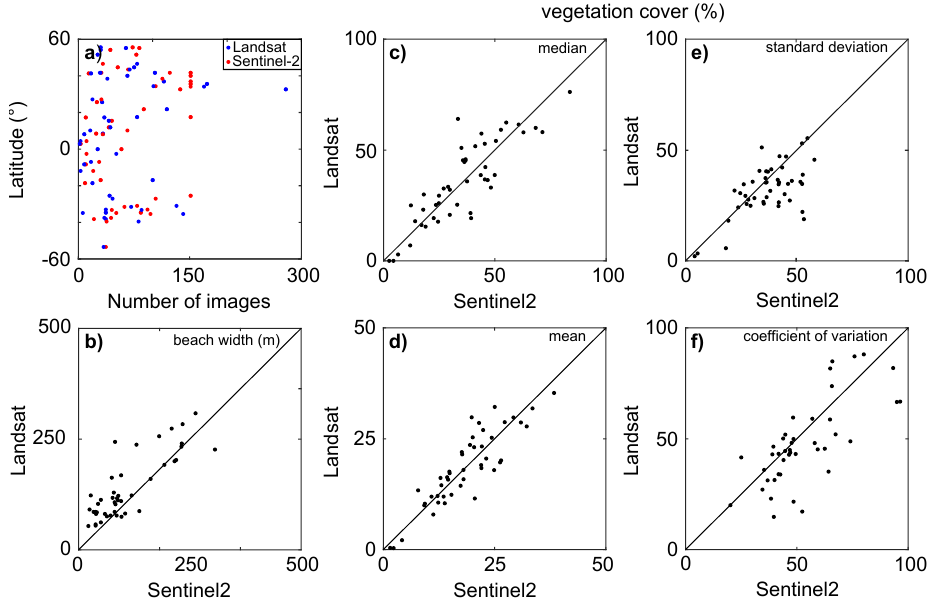
Figure 5. ( a ) Image collection size versus latitude for Landsat (blue dots) and Sentinel-2 (red dots). ( b ) Comparison between the Landsat- and Sentinel-2-derived median beach width (reported in meters). The main vegetation cover statistics expressed as a percentage: ( c ) median; ( d ) mean; ( e ) standard deviation; and ( f ) coefficient of